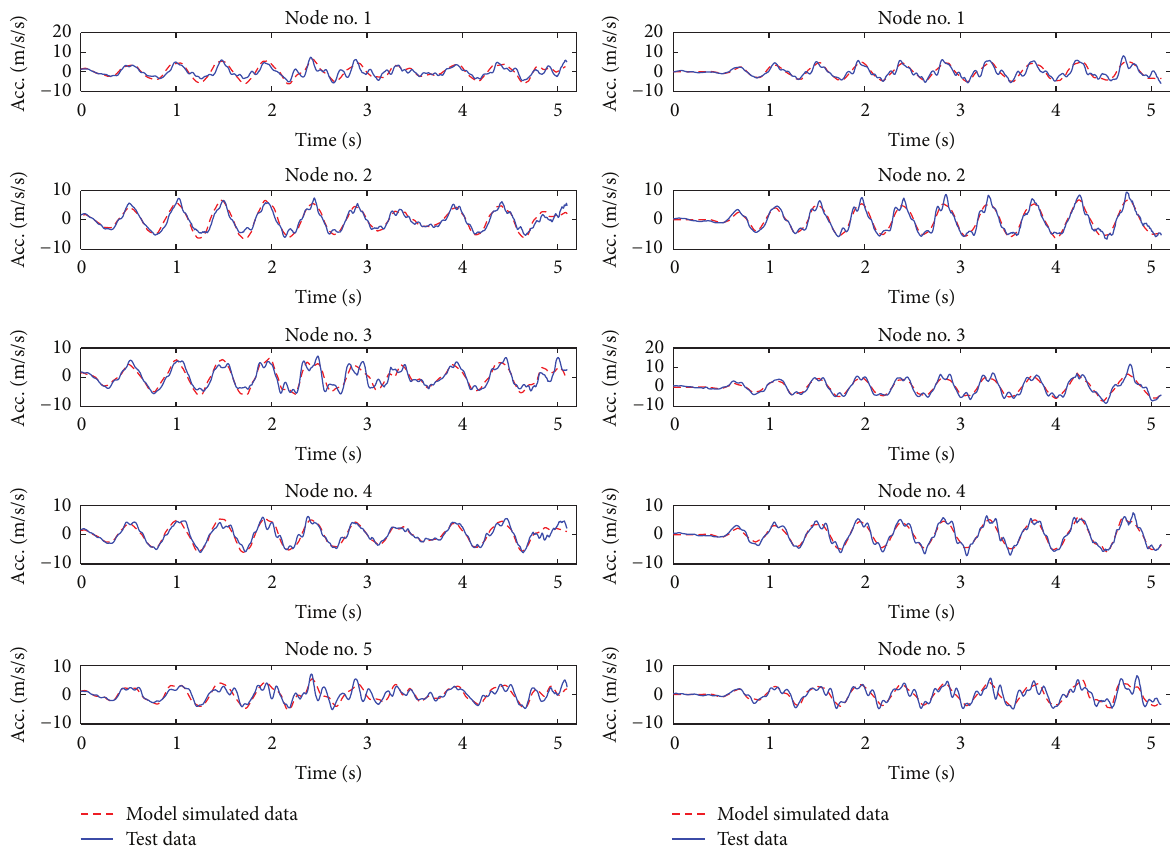
Figure 5: Comparison of two of total six test results (blue solid) and numerical simulation (red dashed) results using identified model.